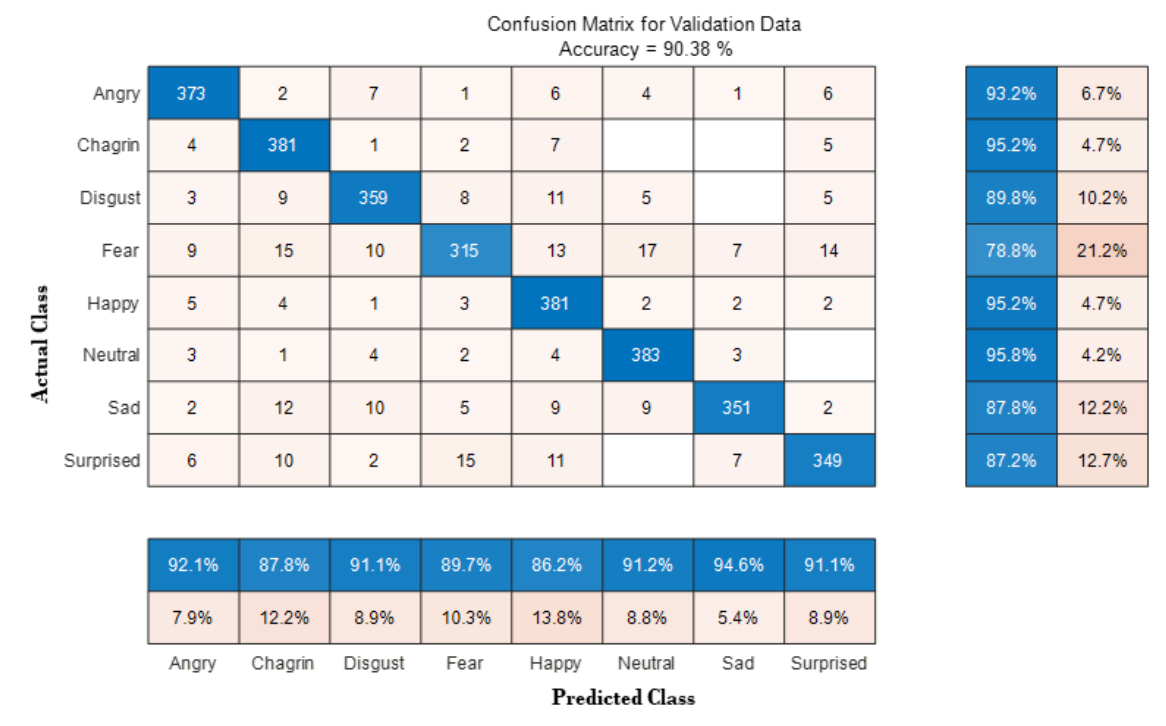
Figure 8. Confusion matrix of Bi-LSTM SER model.